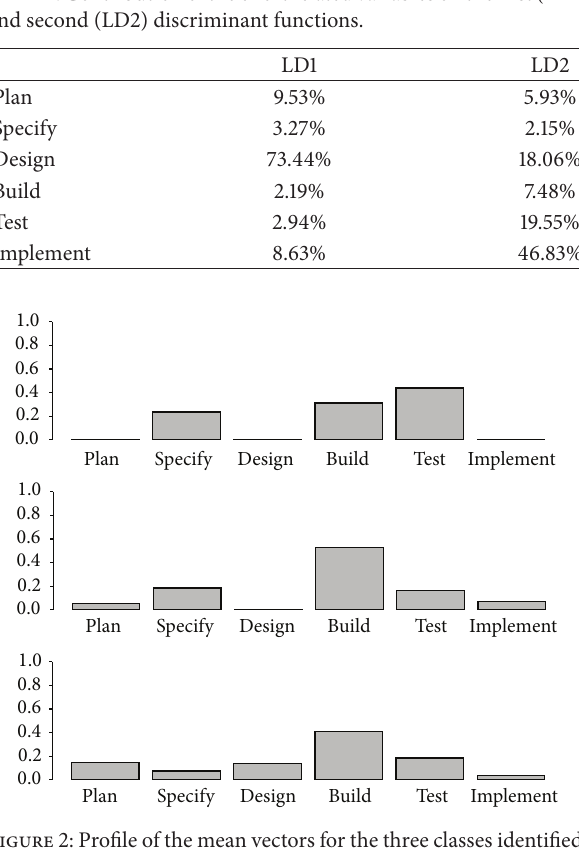
Table 2: Defects prevalence on each of the three identified classes.